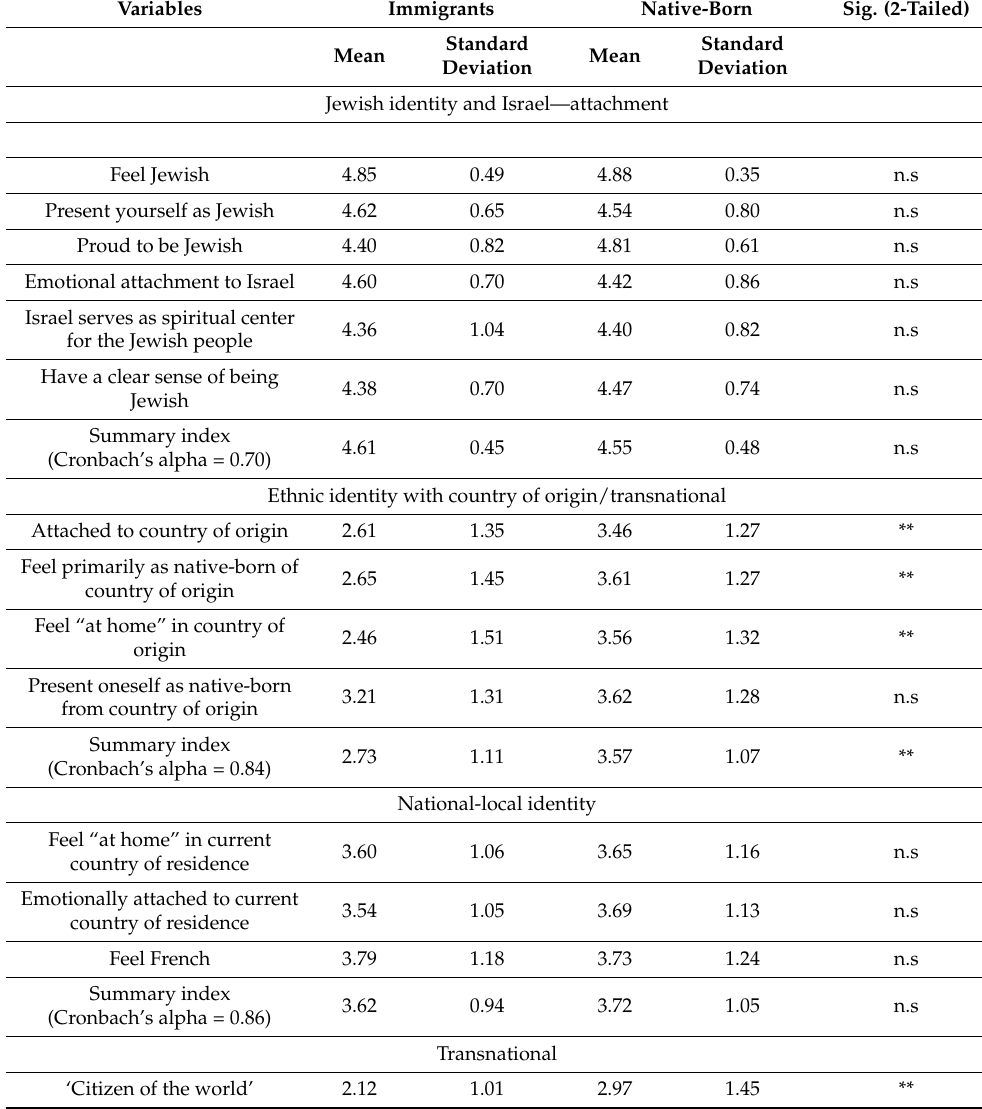
Table 1. Multiple identities: Immigrants and the native-born compared ( t -test analysis for indepen- dent samples, means and standard deviation, 1 = not at all, 5 = to a very large